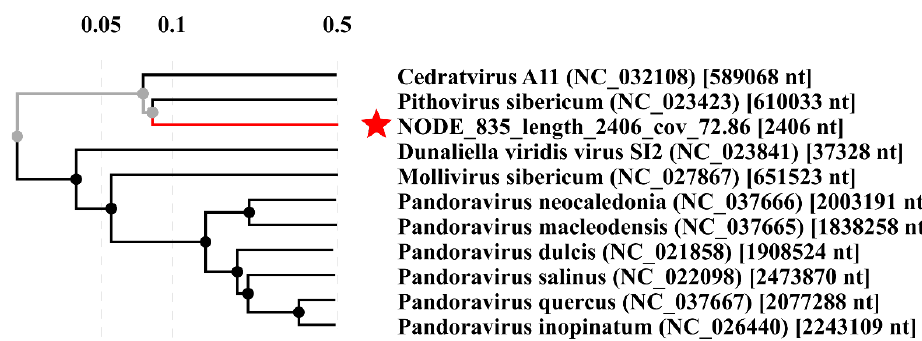
Figure 4. Proteomic tree reconstructed with the Node_835 (RVP3, the sequence is marked with an asterisk) using the ViPTree server.